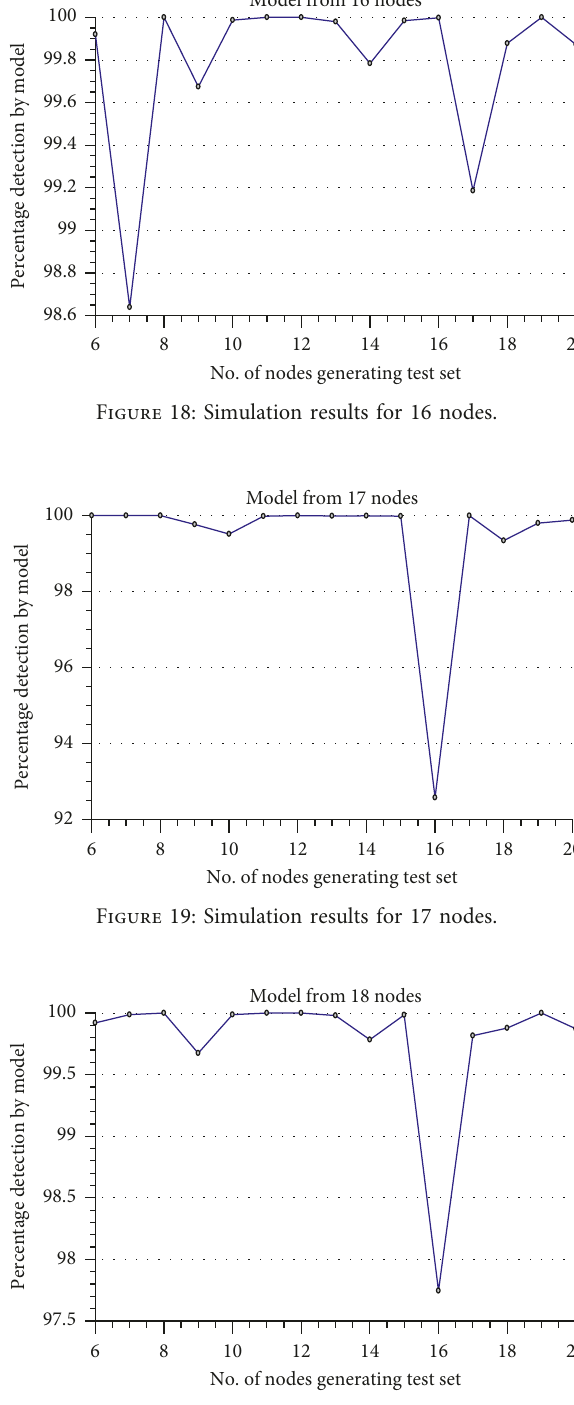
Figure 17: Simulation results for 15 nodes.